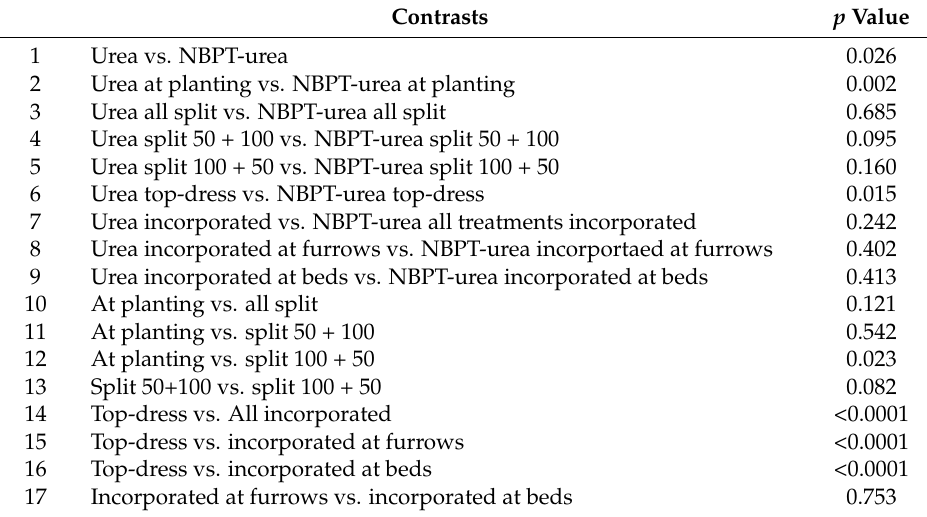
Table A1. Orthogonal contrasts to compare the effects of selected treatments composed of urea sources, timing and methods of fertilizer application on wheat yields in four growing cycles (2010–2011 to 2013–2014), at the International Maize and Wheat Improvement Center (CIMMYT), in the Yaqui valley, near Ciudad Obregon, Sonora,